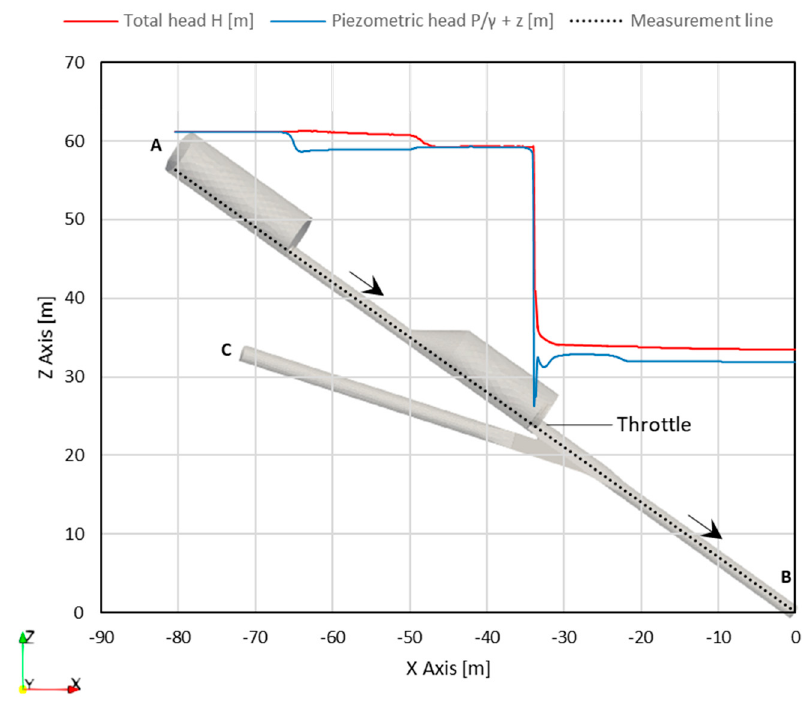
Figure 4. Variation of the total head and piezometric head as plotted along a measurement axis passing through the middle of the pipeline (Q = 14 m 3 / s, in the A-B direction during turbine opening).